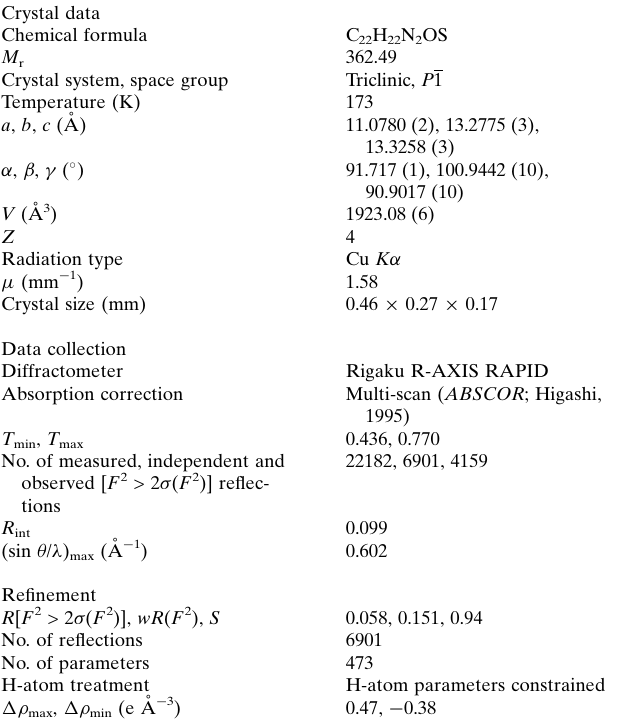
Figure 2 A view of the title compound, showing a pair of C—H (cid:4)(cid:4)(cid:4) O hydrogen bonds (blue dashed lines) forming an R 2 molecule is shown).